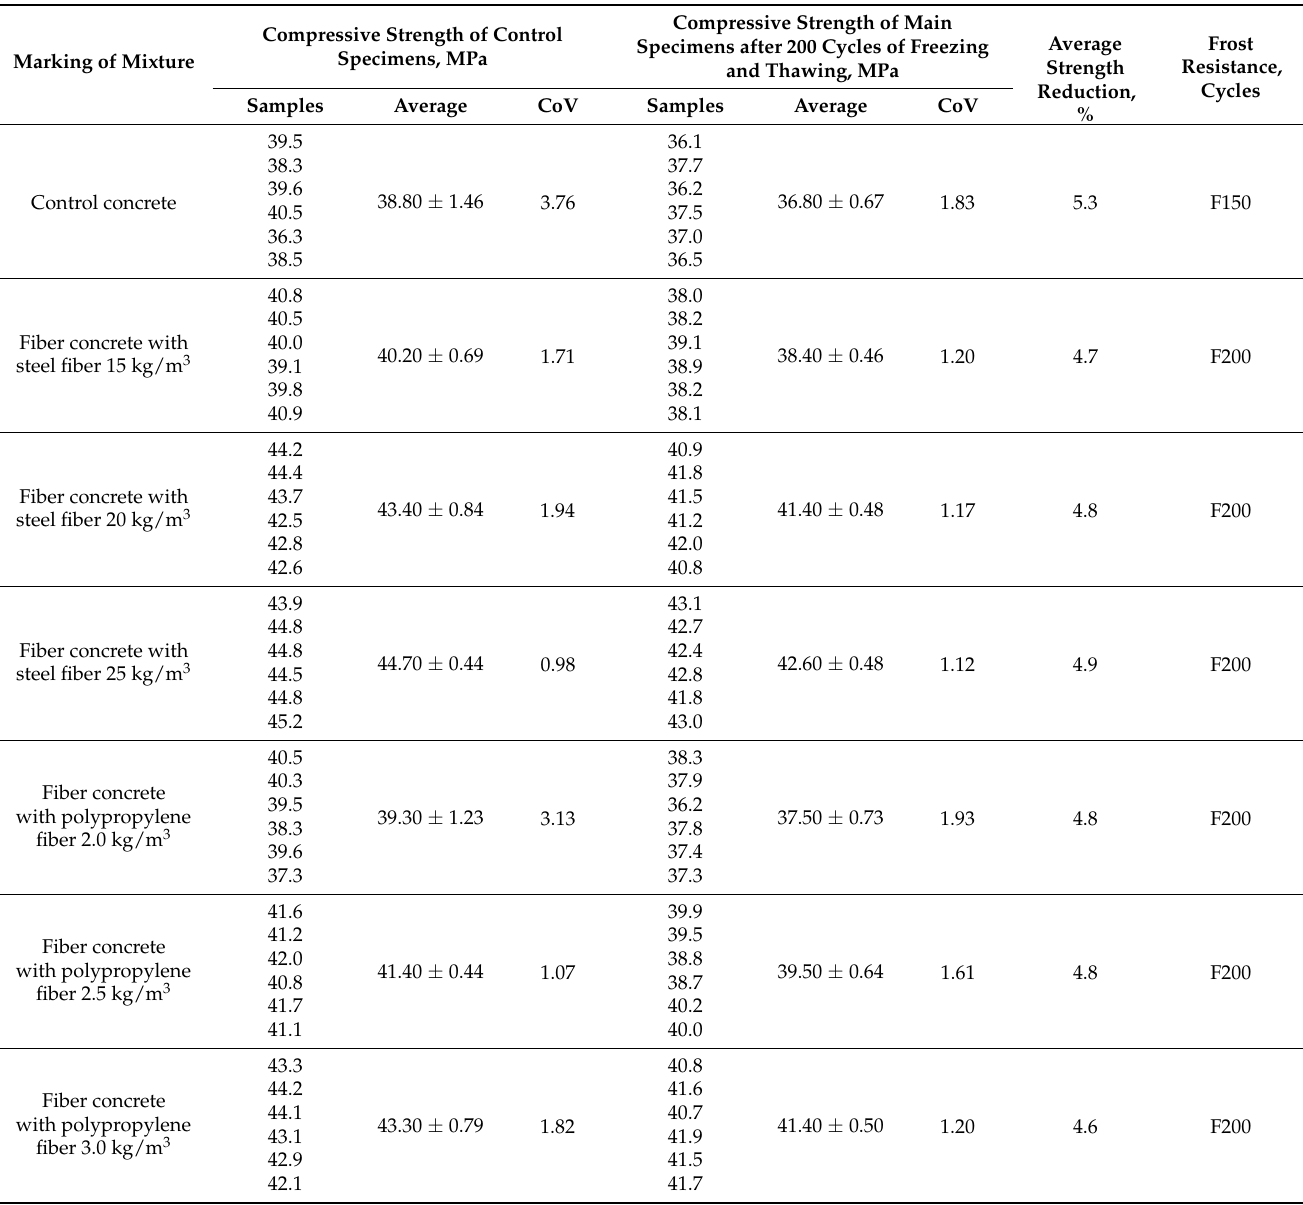
Table 3. Data of fiber-reinforced concrete after frost resistance test (‘ ± ’ indicates standard deviation, ‘CoV’ indicates coefficient of